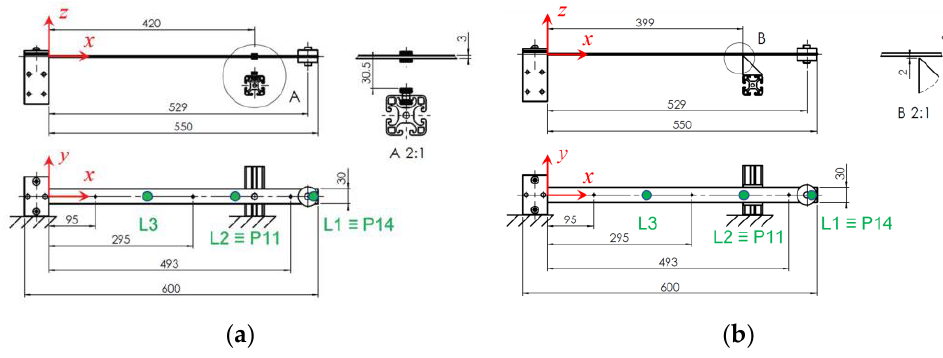
Figure 2. Sketch of the nonlinear system in configurations #2a-#2r ( a ) and #3 ( b ) with relevant dimensions expressed in millimetres.